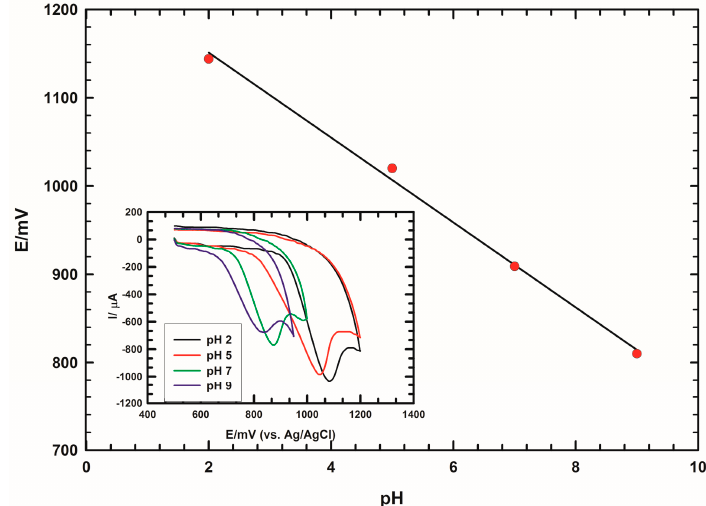
Figure 5. The linear relationship between the anodic peak potential of TZ (mV) and the pH value, scan rate 50 mV·s − 1 , the inset, CVs of 1 mmol·L − 1 TZ/0.1 mol·L − 1 PBS with different pH values (2–9) at ILCCPE…SDS. ILCCPE. . .